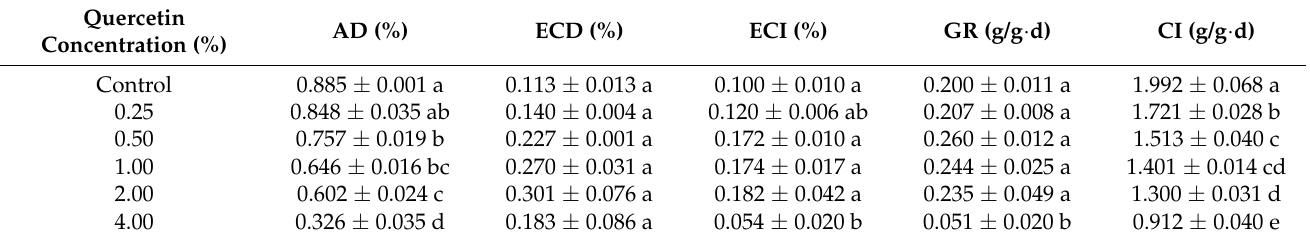
Table 3. Nutritional indices of fifth-instar Hyphantria cunea fed on quercetin and control diets. Quercetin